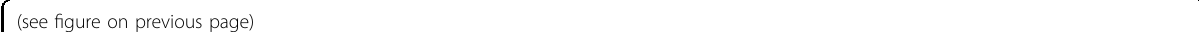
Fig. 7 C3G downregulation enhances ERKs activation in response to serum and FGF2, promoting invasion. A – C Representative western-blot analysis of phosphorylated ERKs levels normalized with β -actin in U87/U87shC3G cells ( A and C ) and 12 Ф 12D/12 Ф 12DshC3G cells. B Serum-deprived cells were maintained untreated ( − ) or treated ( + ) with 10% FBS (FBS) for 10min, either in the presence or absence of PD98059, as indicated. Densitometric analysis of P-ERKs/ β -actin ( A , B ) or P-ERKs/ α -Tubulin ( C ) ratio expressed as the fold increase of the value of untreated cells from the corresponding genotype (non-silenced and C3G silenced) ( n = 3). D Invasion through Matrigel using 10% FBS as chemoattractant. Left panel, representative phase contrast microscopy images of invading cells untreated or treated with PD98059; right panel, histogram showing the mean value ± S.E.M. of the number of invading cells ( n = 3). * p ≤ 0.05, ** p ≤ 0.01, C3G-silenced versus non-silenced cells or compared as indicated. E Anchorage- dependent growth assay in the presence or absence of PD98059. Left panel, representative macroscopic images of foci; right panel, histogram showing the mean value± S.E.M. of foci number ( n = 3). * p ≤ 0.05, C3G silenced versus non-silenced cells or compared as indicated. F Anchorage- independent growth assay in cells maintained untreated or treated with PD98059. Left panel, representative images of a microscopic view of foci; right panel, histogram showing the mean value± S.E.M. of the total foci number per fi eld ( n = 4). *** p ≤ 0.001, C3G silenced versus non-silenced cells or compared as indicated. G Cell cycle analysis by fl ow cytometry. Histogram represents the percentage of cells in S and G2/M phases of cell cycle± S.E.M. ( n = 3). * p ≤ 0.05, C3G silenced versus non-silenced cells or compared as indicated. H Immuno fl uorescence analysis of Ki67 (red)/DAPI (blue) staining. Upper panel, representative images; lower panel, histogram showing the percentage of Ki67 positive cells (mean value ± S.E.M.). I Representative western-blot analysis of P-ERKs levels in response to FGF2 stimulation (5 – 10min) normalized to β -actin. Densitometric analysis of P-ERKs/ α -tubulin ratio expressed as the fold increase of the value of untreated cells from the corresponding genotype (non-silenced and C3G silenced) ( n = 3). J Invasion through Matrigel in response to FGF2 in the absence and presence of PD98059. *** p ≤ 0.001, compared as indicated. Scale bars: